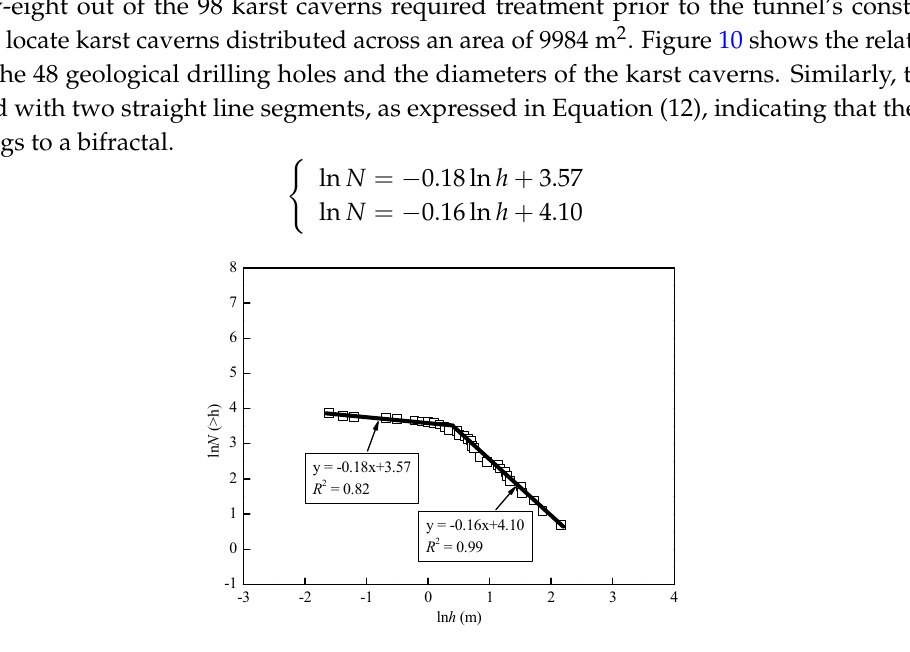
Figure 10. Fractal model describing the relationship between the 48 geological drilling holes and the diameters of the karst caverns.